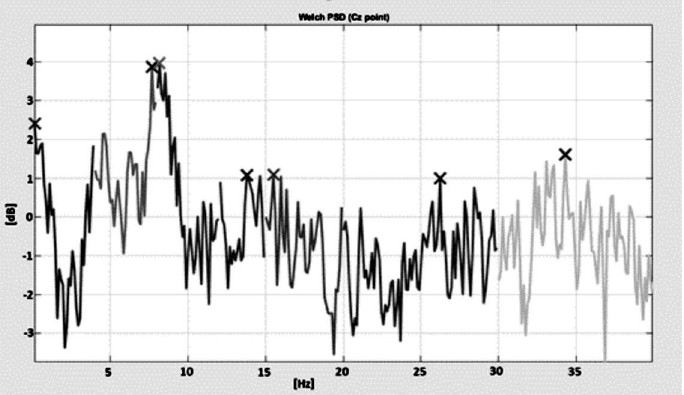
Figure 12. Welch’ s